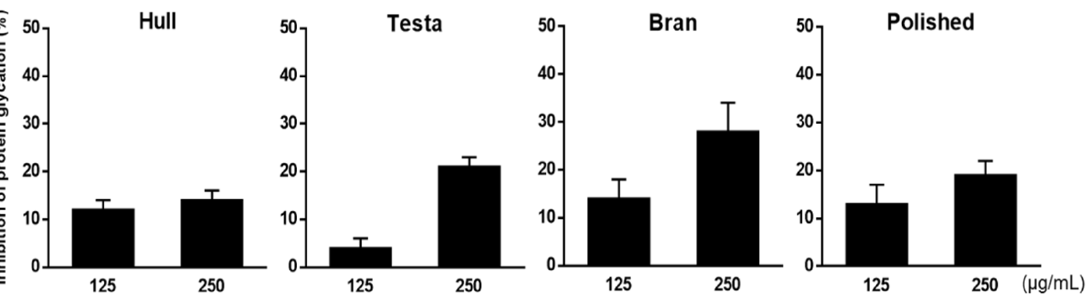
Figure 2. Effects of ethanolic extracts of adlay hull (AHE), adlay testa (ATE), adlay bran (ABE), and polished adlay (PAE) on glucose-mediated development of fluorescence of AGEs (BSA-glucose assay). Results are means ± SD for n = 3.